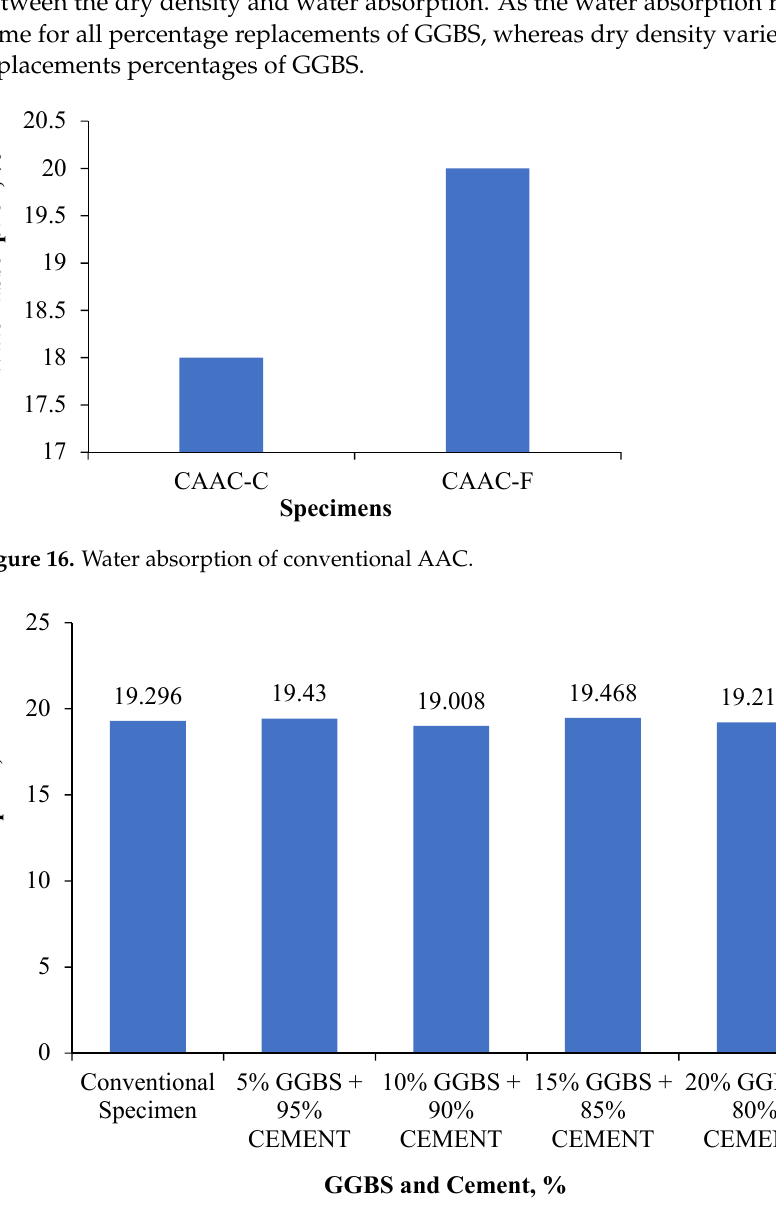
Figure 17. Water absorption of GGBS incorporated in AAC.